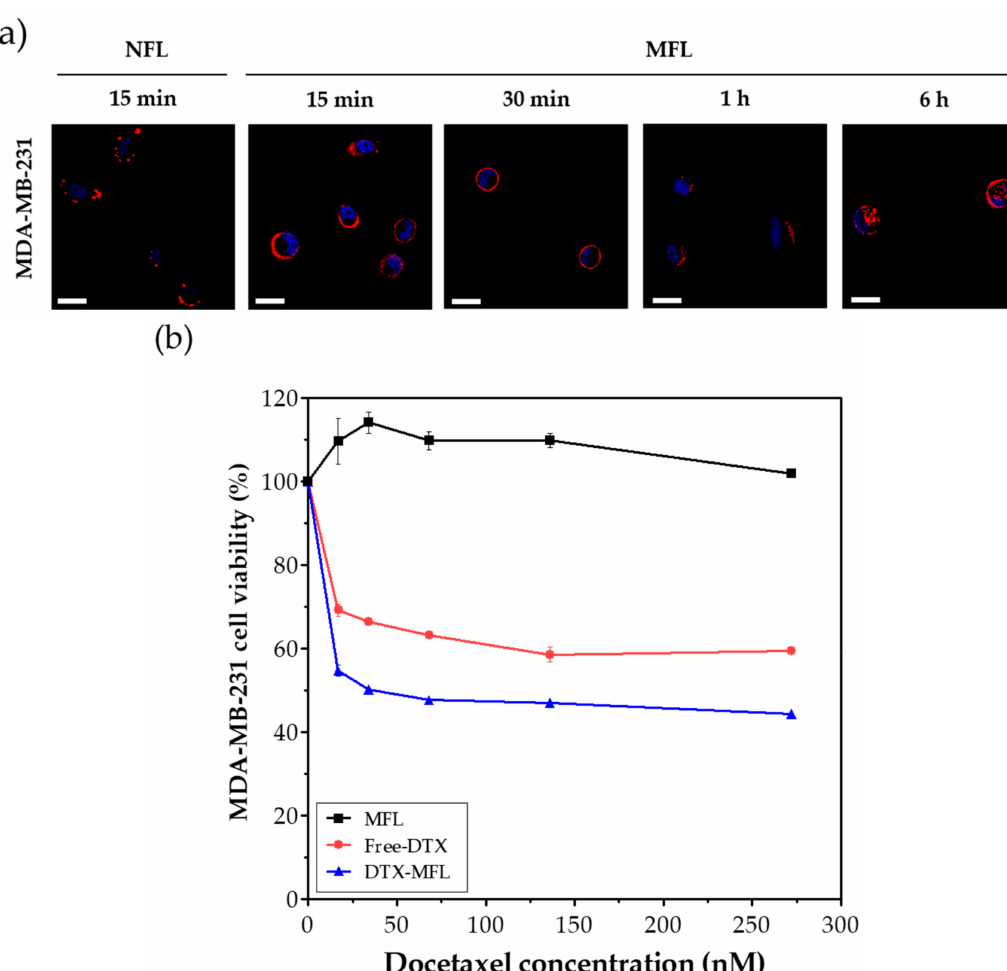
Figure 3. ( a ) Confocal fluorescent microscopic images of MDA-MB-231 cells treated with membrane fusogenic liposomes and non-fusogenic liposomes loaded with fluorescent dye DiI. ( b ) Cell viability of MFLs, free-DTX, and DTX-MFLs at 24 h. MFL and NFL denote membrane fusogenic liposomes and non-fusogenic liposomes, respectively. Nuclei were stained with Hoechst (blue). Scale bars represent 20 µ